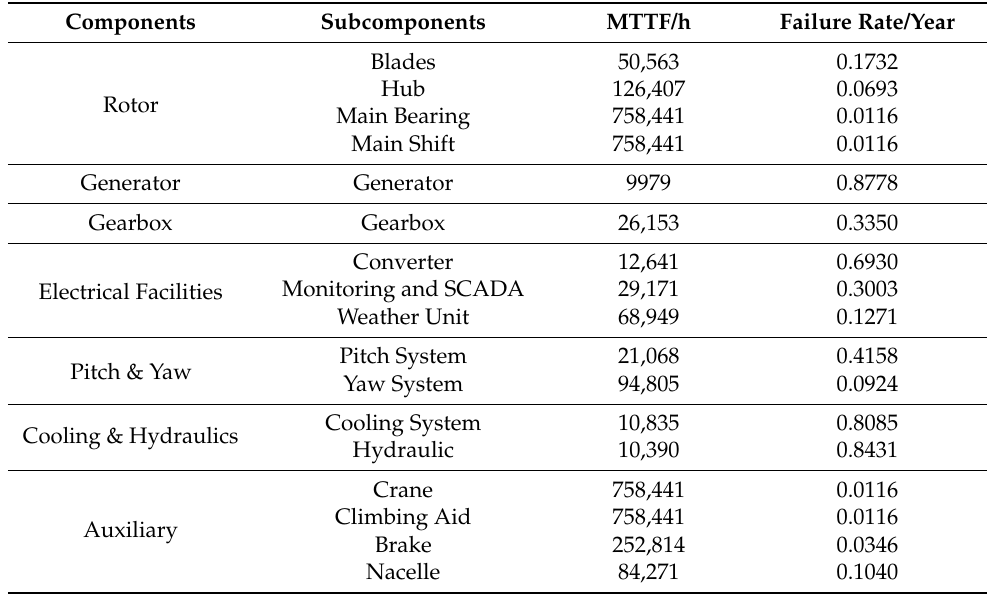
Table 6. Failure rates and MTTFs of